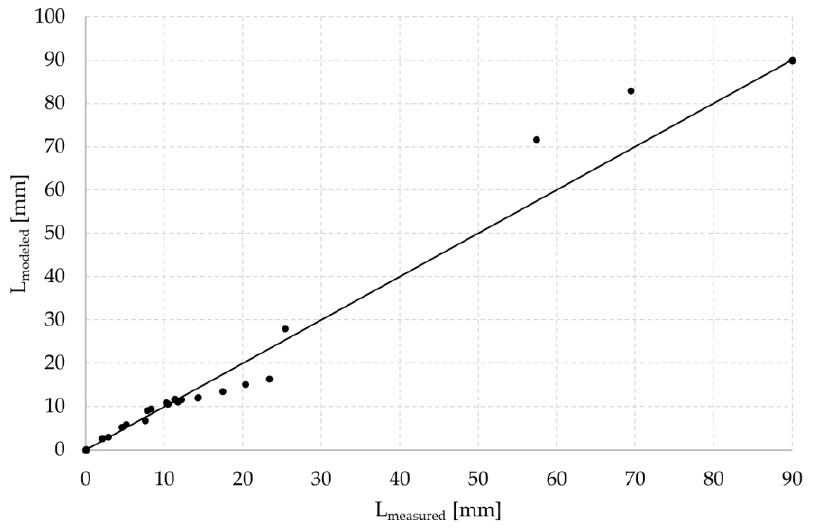
Figure 15. Cavitation model for the modified hydrofoil, coefficient of determination R 2 = 0.9858.